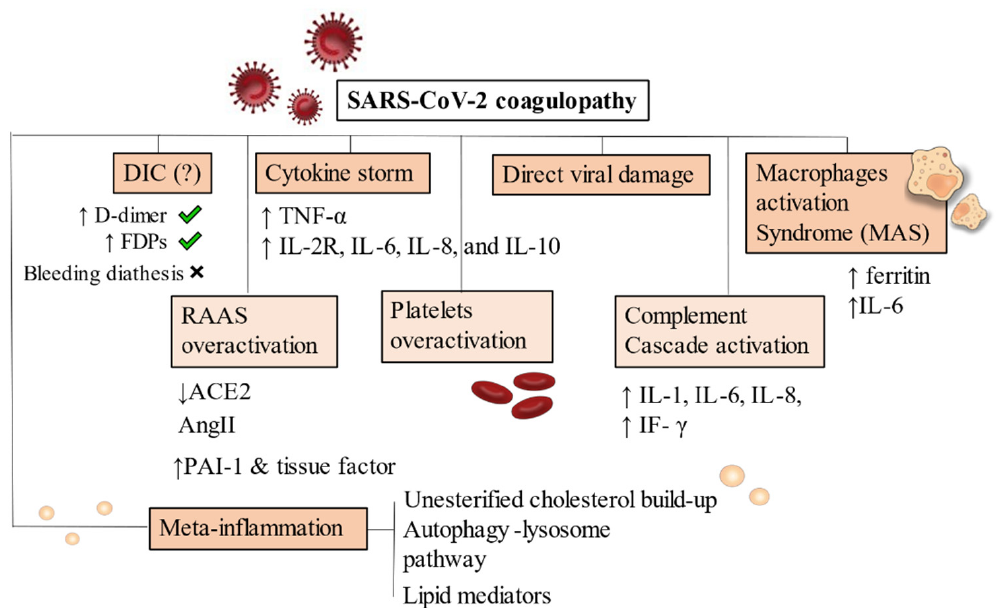
Figure 2. Pathophysiology of SARS-CoV-2 coagulopathy. DIC has been frequently noticed in Covid-19 severe patients but bleeding diathesis was a less present feature. Cytokine storm and inflammatory-driven thrombogenesis is the most known hypothesis, due to IL-2R, IL-6, IL-8, and IL-10 cascade generation. A direct viral damage has also been acknowledged to start endothelitis and endothelial damage. MAS is instead an added mechanism present on an already compromised immune condition where hyperferritinaemia and increase in IL-6 production are pathognomonic of macrophages overactivation. RAAS system, complement and platelets also drive uncontrollable responses by generating hypercytokinemia and dysregulating fibrinolysis. Increased levels of PAI-1 and tissue factor have been demonstrated. Meta-inflammation is another possible trigger for coagulopathy. Obesity, hyperinsulinemia and metabolic syndrome are strong risk factors for severity of infection in hospitalized patients. Primary conditions developing after viral infection are depicted with a darker background. RAAS overactivation, platelets and complement activation are mainly secondary mechanisms, thus they appear in a lighter background. Abbreviations :